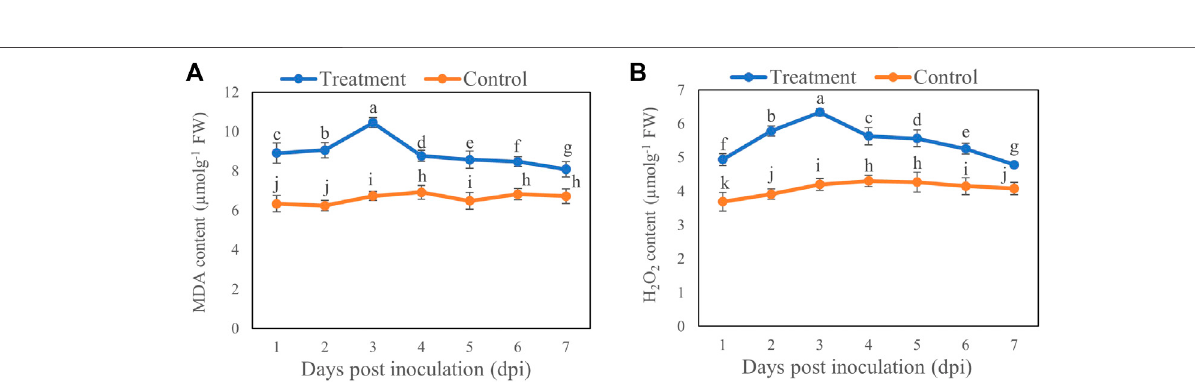
Frontiers in Physiology |